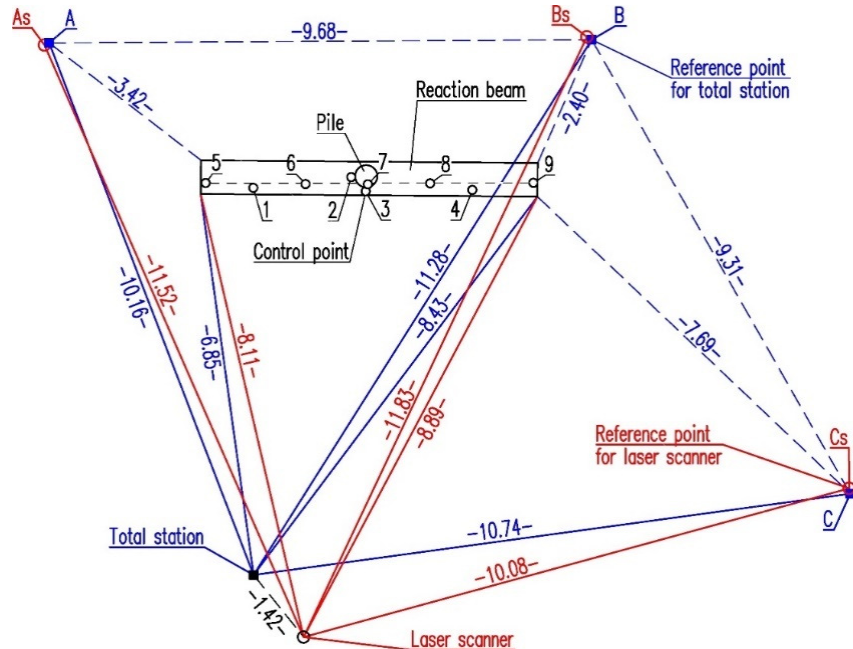
Figure 3. Arrangement of measuring instruments and reference points.